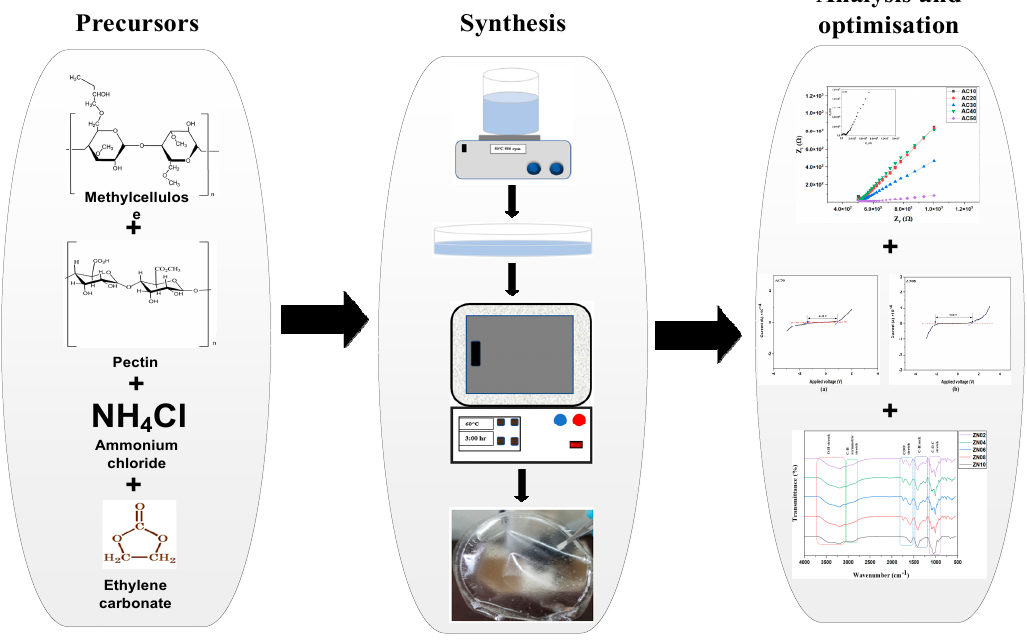
Figure 1. Schematic representation of NCSPE synthesis and optimisation .